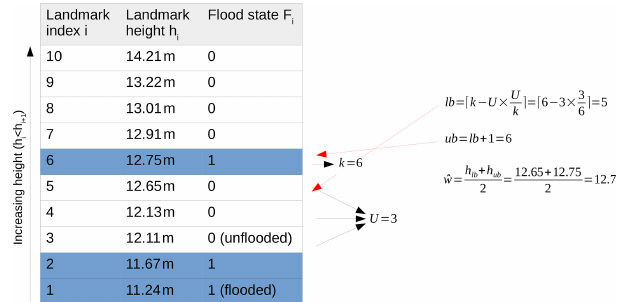
Figure 4. Example application of the LBWLE algorithm. The prin- ciple is that if some of the highest landmarks are estimated as flooded but some lower height landmarks are estimated as un- flooded, then the true water level is likely lower than the height of the highest landmark estimated as